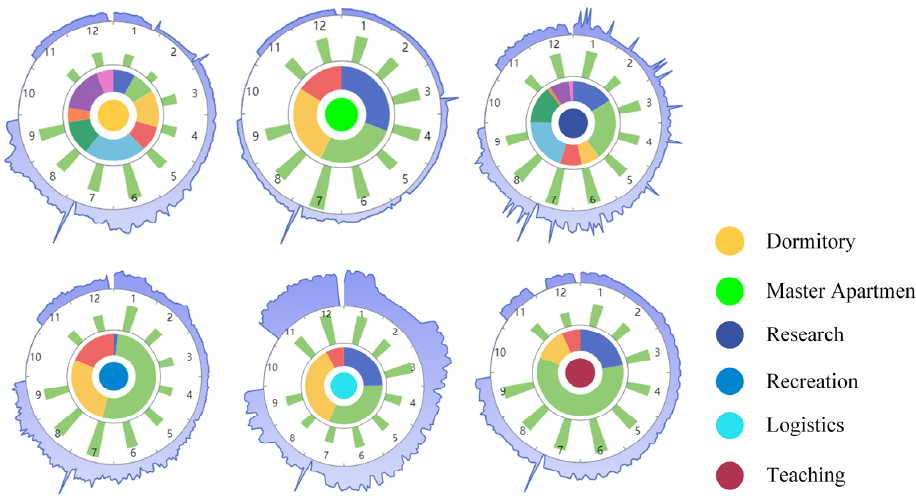
Figure 13. Differences in electricity consumption among user groups.